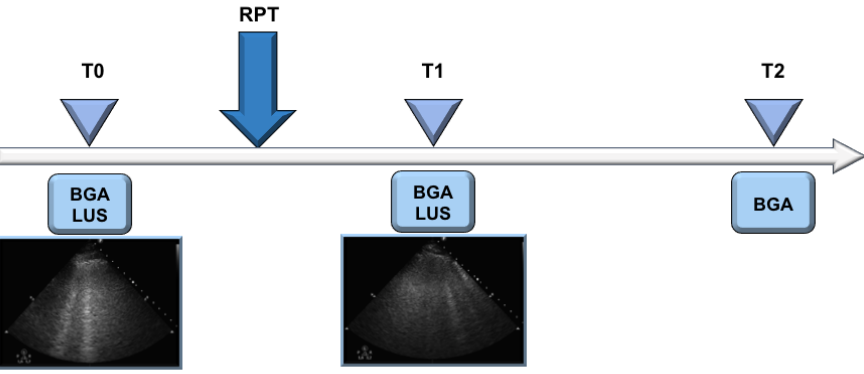
Figure 2. This figure represents the three timepoints of our pre-post study. At baseline/before RPT (T0) a lung echography (LUS) and a blood gas analysis (BGA) were assessed, followed by a RPT protocolized session; then, a new LUS and BGA immediately after RPT (T1) and 6 h thereafter (T2) were collected.